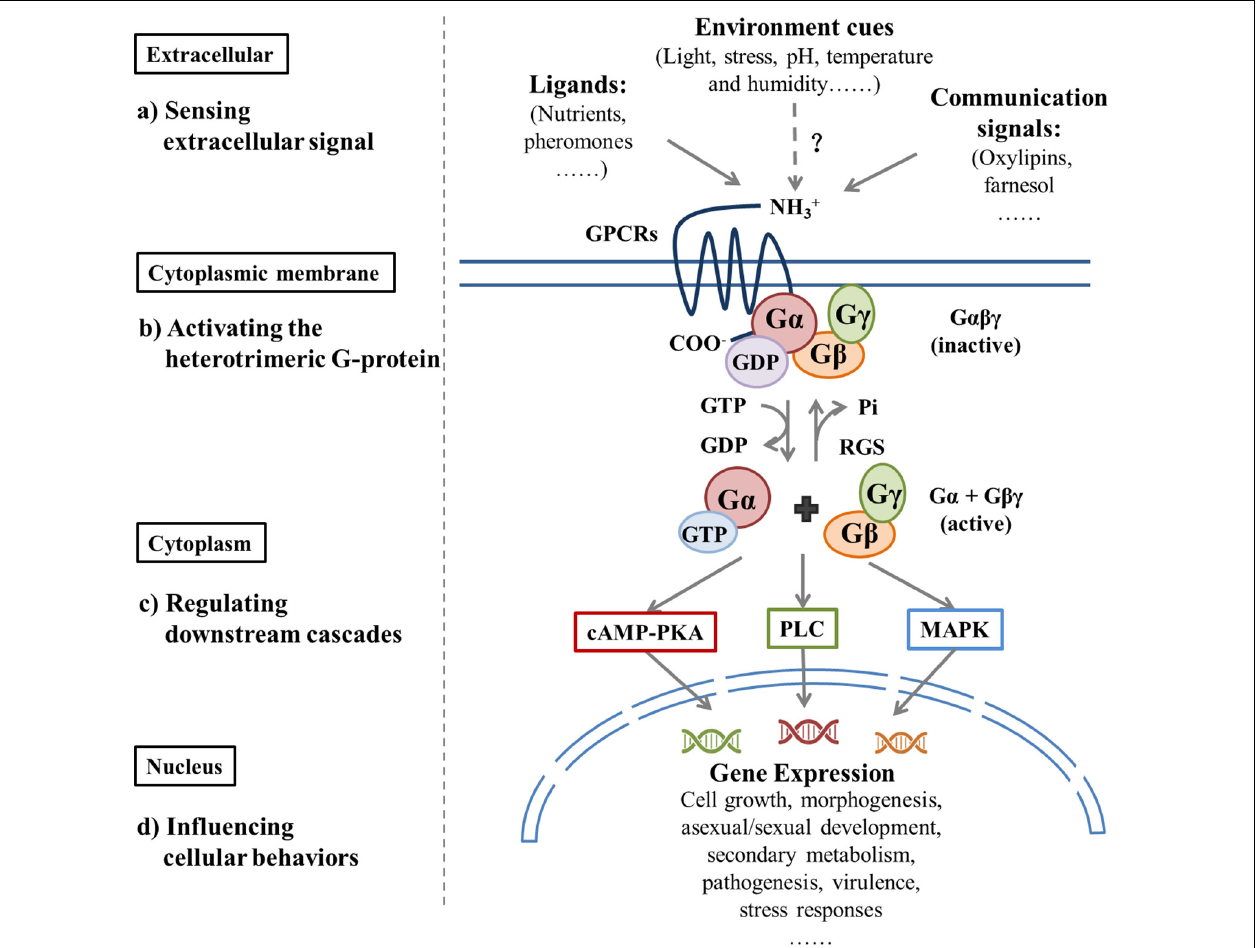
FIGURE 1 | Extracellular signals regulate downstream pathways by activating G protein signaling and, thus, influence cellular behavior.| Different classes of GPCRs sense various extracellular factors, which include ligands, environmental cues, and communication signals that bind to the GPCR; this causes GDP-GTP exchange on the G α protein and dissociation of G α and G βγ . Both the G α -GTP and G βγ dimers may trigger respective downstream signal cascades, which include the cAMP-activated Protein Kinase A (PKA) pathway, mitogen-activated protein kinase (MAPK) cascades pathway, and the phospholipase C (PLC) pathway. This process influences cellular growth, reproduction, metabolism, virulence, and stress responses. GTP hydrolysis by the G α subunit results in the reassociation of G α -GDP with the G βγ dimer and GPCR, which completes the G protein cycle. The Regulator of G-protein Signaling (RGS) proteins can inactivate G protein signaling rapidly by increasing intrinsic GTPase activity of GTP-bound G α subunits. In this figure, dashed arrows with the question mark (?) indicates hypothetical